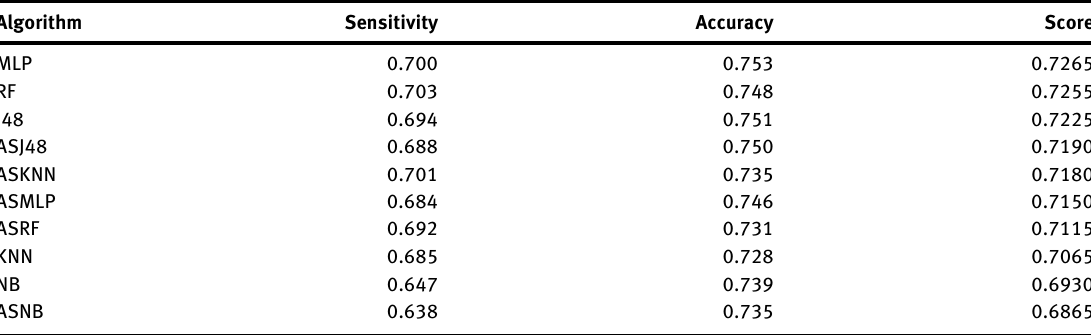
Table 4: Sensitivity, accuracy and score values obtained for training data.